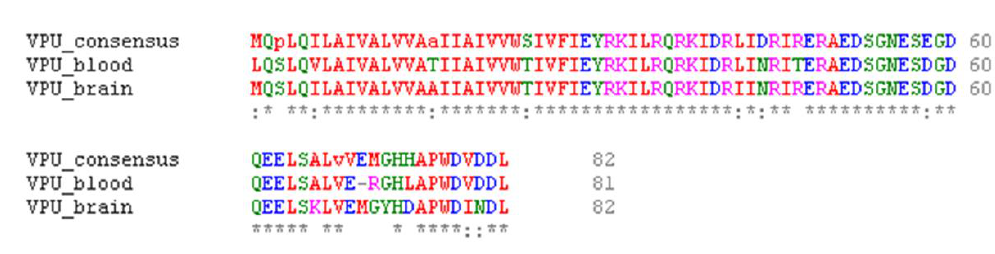
Figure 1. Representation of identity (*) and conserved substitutions (:) between human immunodeficiency virus (HIV)-1 Viral Protein U (Vpu) sequences from blood and brain isolates and the consensus Vpu sequence .